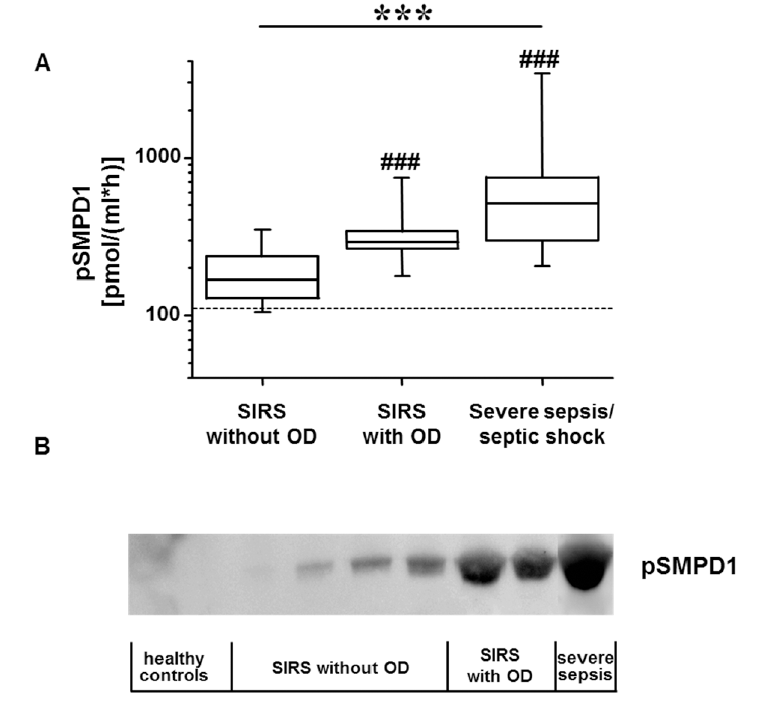
Figure 1. Activity of pSMPD1 during the course of inflammatory response. (A) Activity was determined by densitometric quantification of generated ceramide from a fluorescent dye-labeled sphingomyelin substrate in serum from patients with various degrees of inflam- matory response with postoperative SIRS after cardiac surgery without organ dysfunction ( SIRS without OD ), with SIRS with organ dysfunction ( SIRS with OD ) and severe sepsis/septic shock ( severe sepsis/septic shock ). Boxes indicate interquartile range, divided by the me- dian (central horizontal line). The median of an age-matched healthy control cohort is in- dicated by a dotted horizontal line. Levels of significance between patients groups are in- dicated by asterisks (*** P ≤ 0.001; Kruskal-Wallis-test) and between the patients groups with OD versus SIRS without OD by a rhombus (### P ≤ 0.001; MWU-test). (B) Plasma appearance of SMPD1 determined by immuno-precipitation and immunological visualization. Results shown are representative of those obtained in three independent